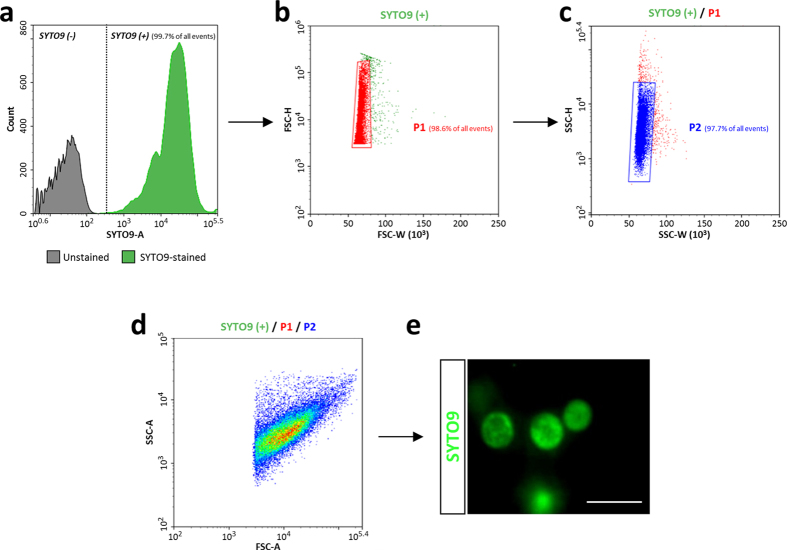
Detection of endosymbionts by flow cytometry analysis.(a–d) Gating strategy used to analyze B. aphidicola cells. (a) Fluorescence histogram overlay of unstained and SYTO9-stained samples, with the dotted line referring to the autofluorescence limit. SYTO9 positive events were selected, and debris excluded from the analysis. (b) SYTO9 positive events were viewed in a FSC-W/FSC-H plot to select cells homogeneous in size (gate P1) and depict cell doublets/aggregates. (c) Events in gate P1 were viewed in a SSC-W/SSC-H plot to select cells homogeneous in granularity (gate P2). (d) Cells identified as B. aphidicola were represented on density plot (FSC-A/SSC-A), the color gradient indicating increasing density of dots. (e) Microscopy image of SYTO9-stained symbionts. Scale bars = 5 μm.